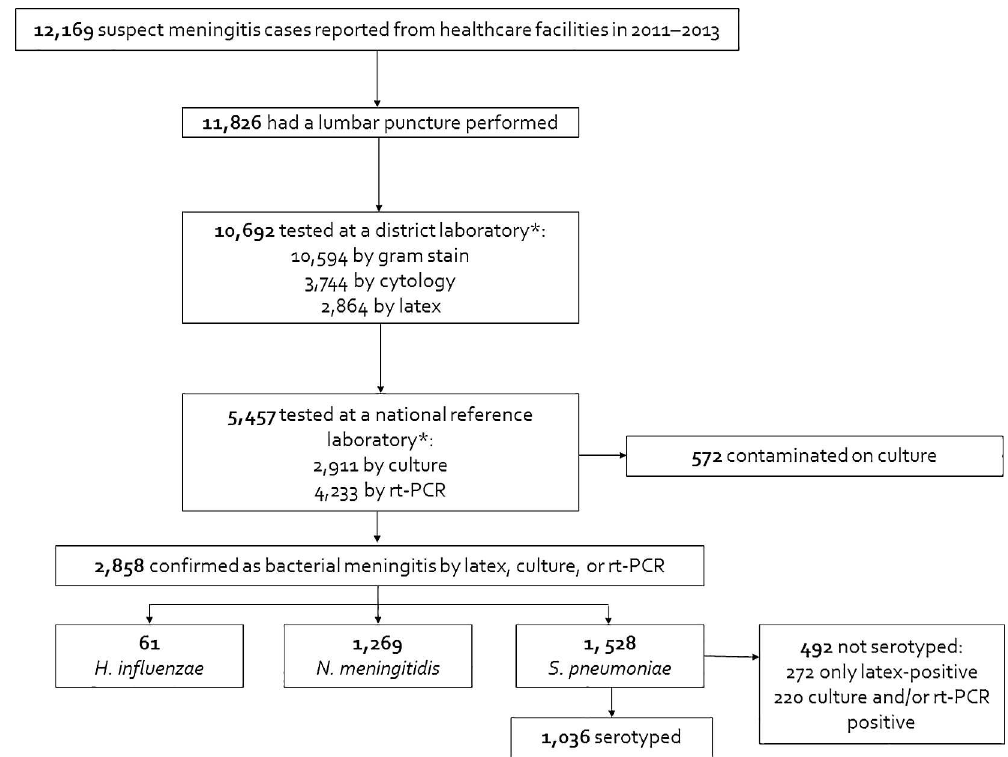
Fig 1. Flow diagram of the national case-basedmeningitis surveillance system, Burkina Faso, 2011–2013. Abbreviation: rt-PCR, real-time polymerase chain reaction. * Specimens can be tested by multiple methods.